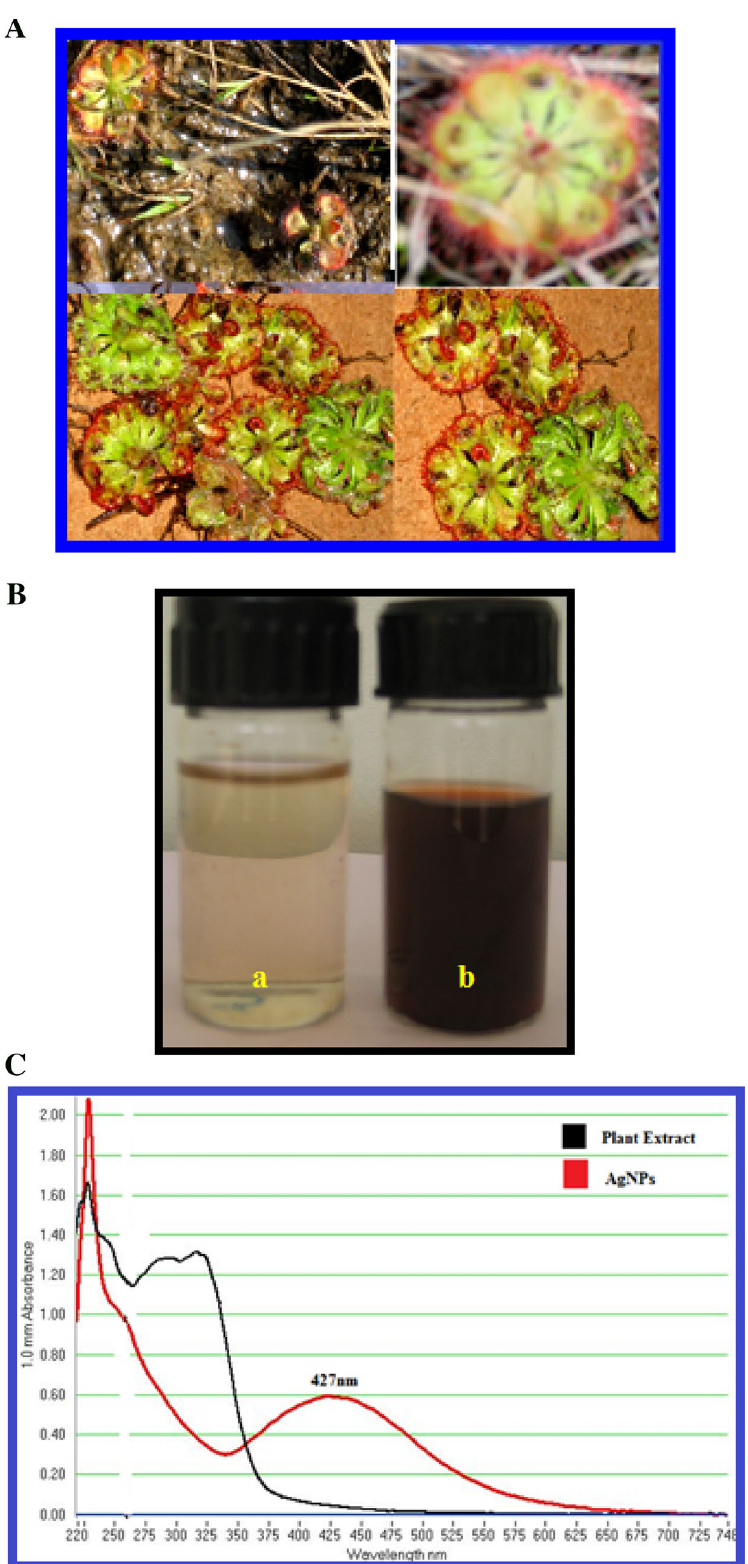
Figure 1. ( A ) Drosera spatulata plant. ( B ): (a) Plant extract of Drosera spatulata . (b). Biosynthesized Ds-AgNPs by Plant extract of Drosera spatulata . ( C ): UV–VIS absorption spectra of Drosera spatulata plant extract (black spectrum) and UV–VIS absorption spectra of Ds-AgNps synthesized from Drosera spatulata plant extract with 0.002 M silver nitrate (red